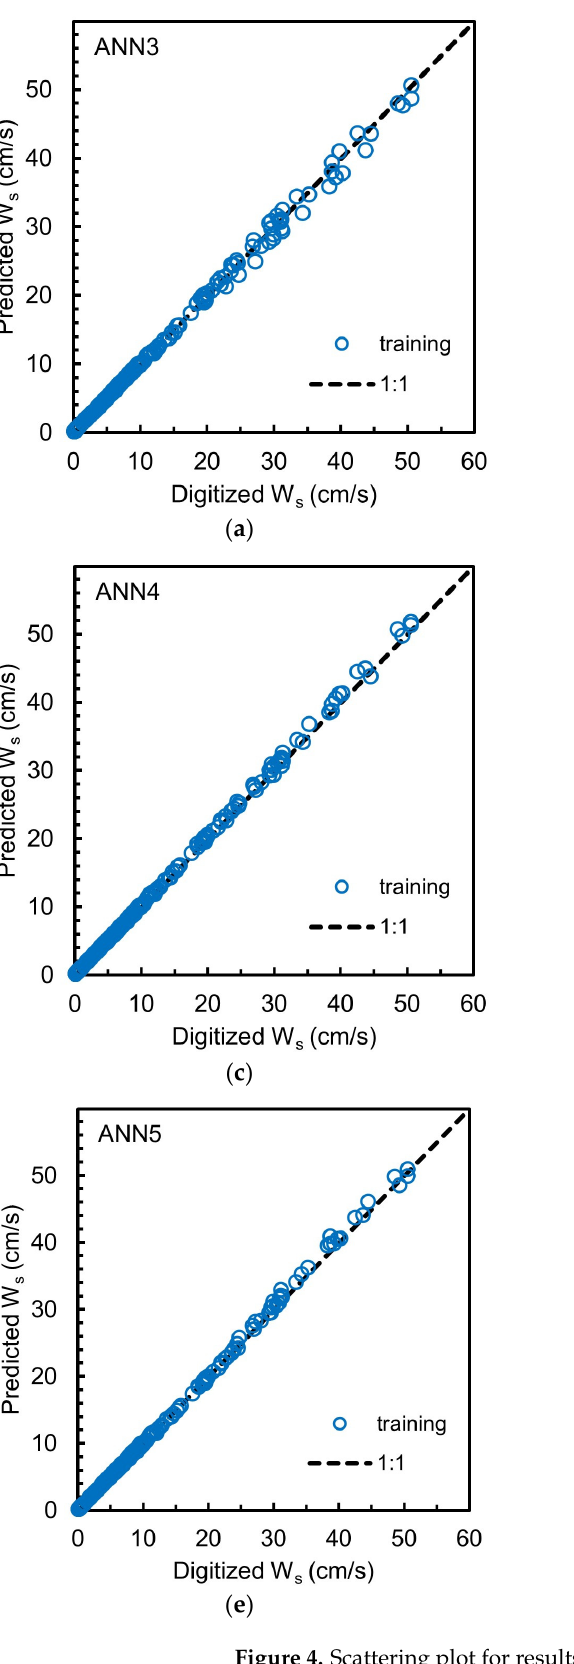
Figure 4. Scattering plot for results of training (left panel); validation and testing 1 (right panel) for ANN3 ( a , b ); ANN4 ( c , d ) and ANN5 ( e , f ).